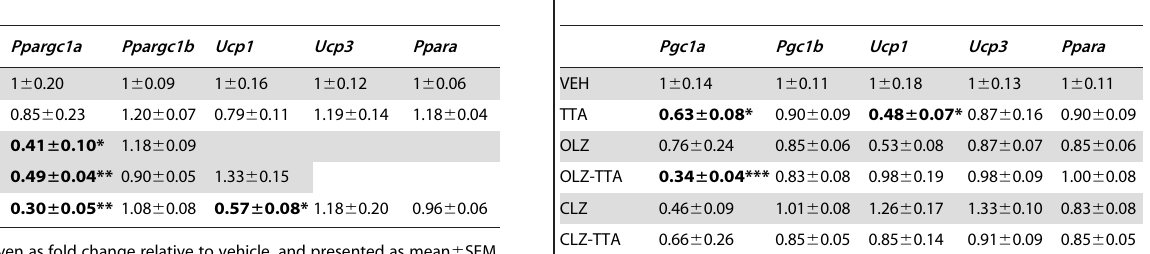
Data are given as fold change relative to vehicle, and presented as mean 6 SEM. Data shown are normalised to P0 ( Arbp ), with comparable results when normalised to b -actin . *P # 0.05 vs vehicle.